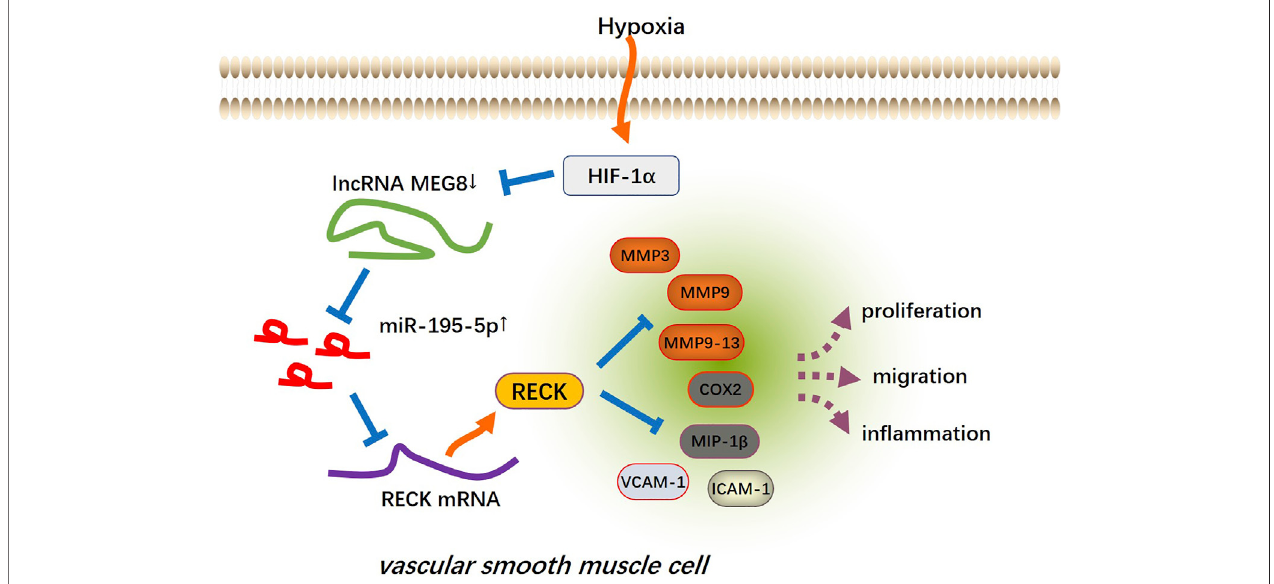
FIGURE 8 | The mechanism ’ s diagram. The up-regulation of MEG8 in hypoxia-induced VSMCs uplifted the expression of RECK by targeting and inhibiting miR- 195-5p, thus reducing excessive cell proliferation, in fl ammation and